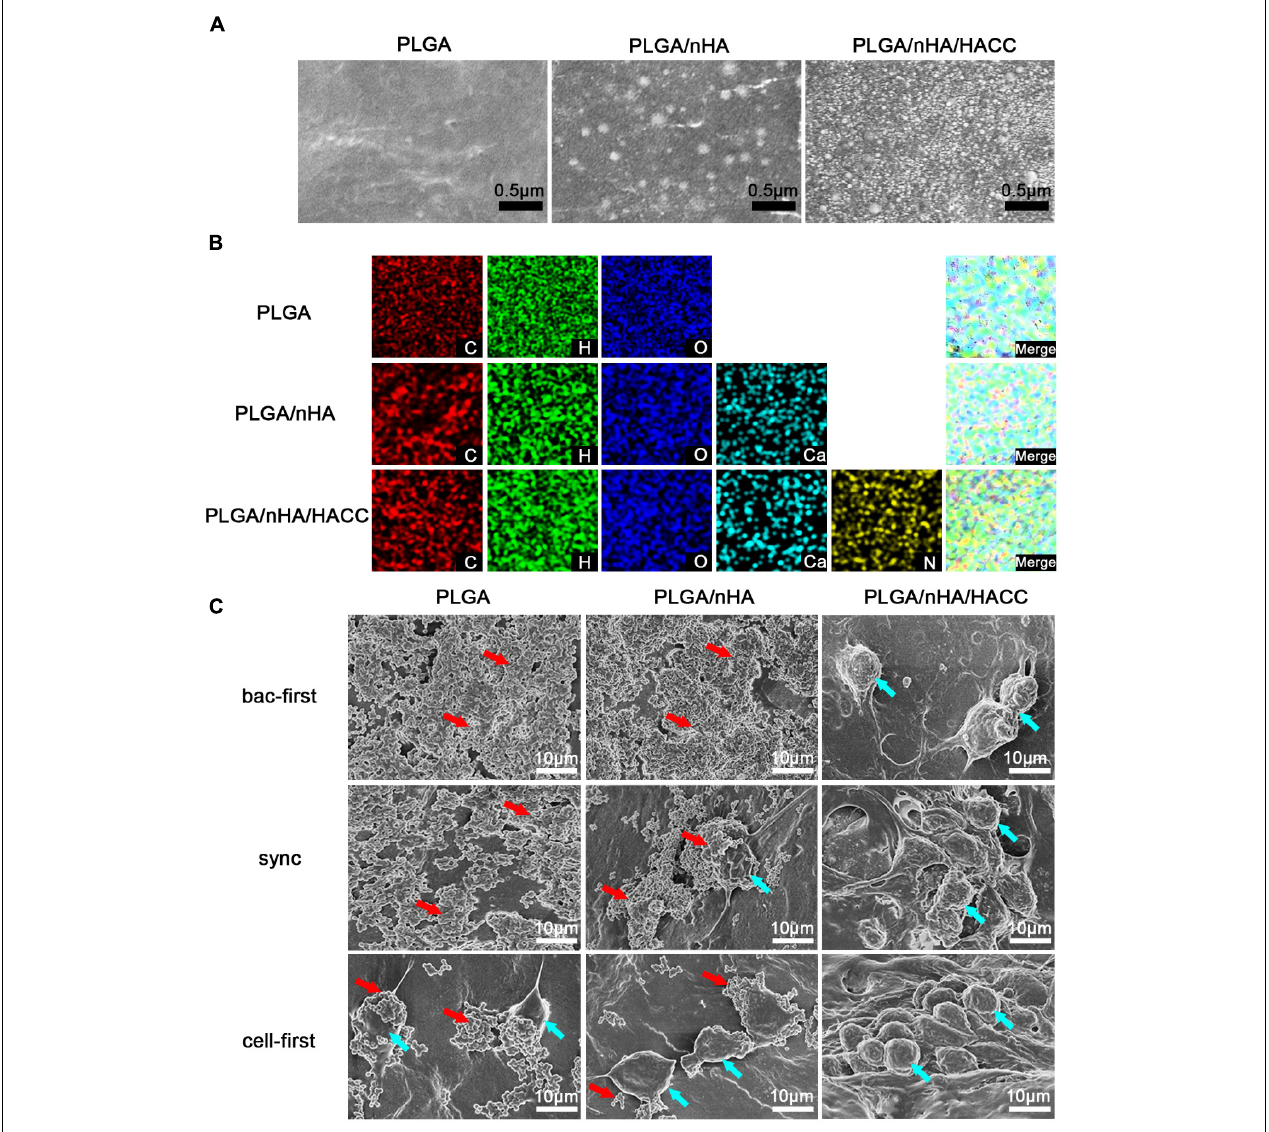
FIGURE 2 | (A) SEM images of the different materials surfaces. (B) EDS mapping showing the C, H, O, Ca, and N elements of different materials. (C) SEM observations of MC3T3-E1 cells and S. aureus morphology on different materials surfaces in different co-cultured systems. Blue arrows indicate cell colonization and red arrows indicate bacterial colonization in the